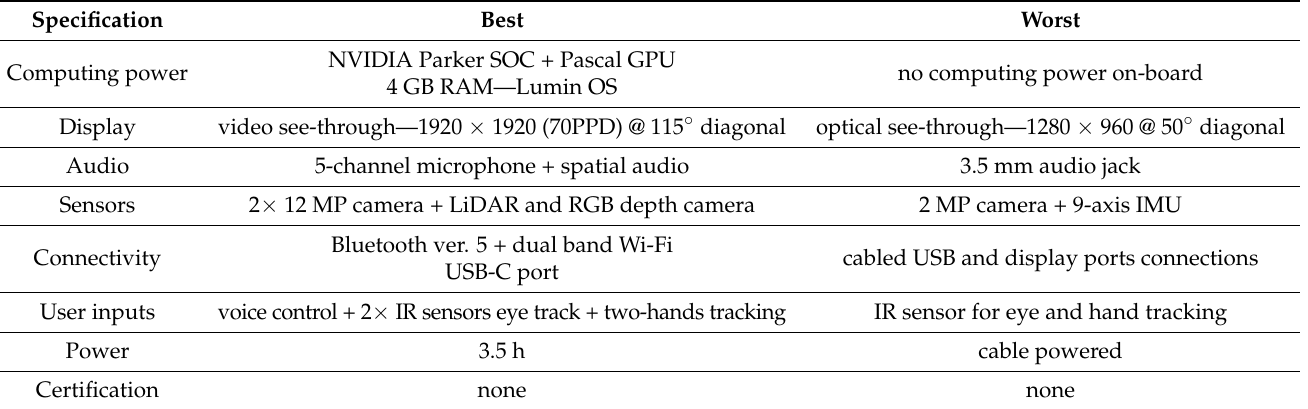
Table 4. Professional HMD